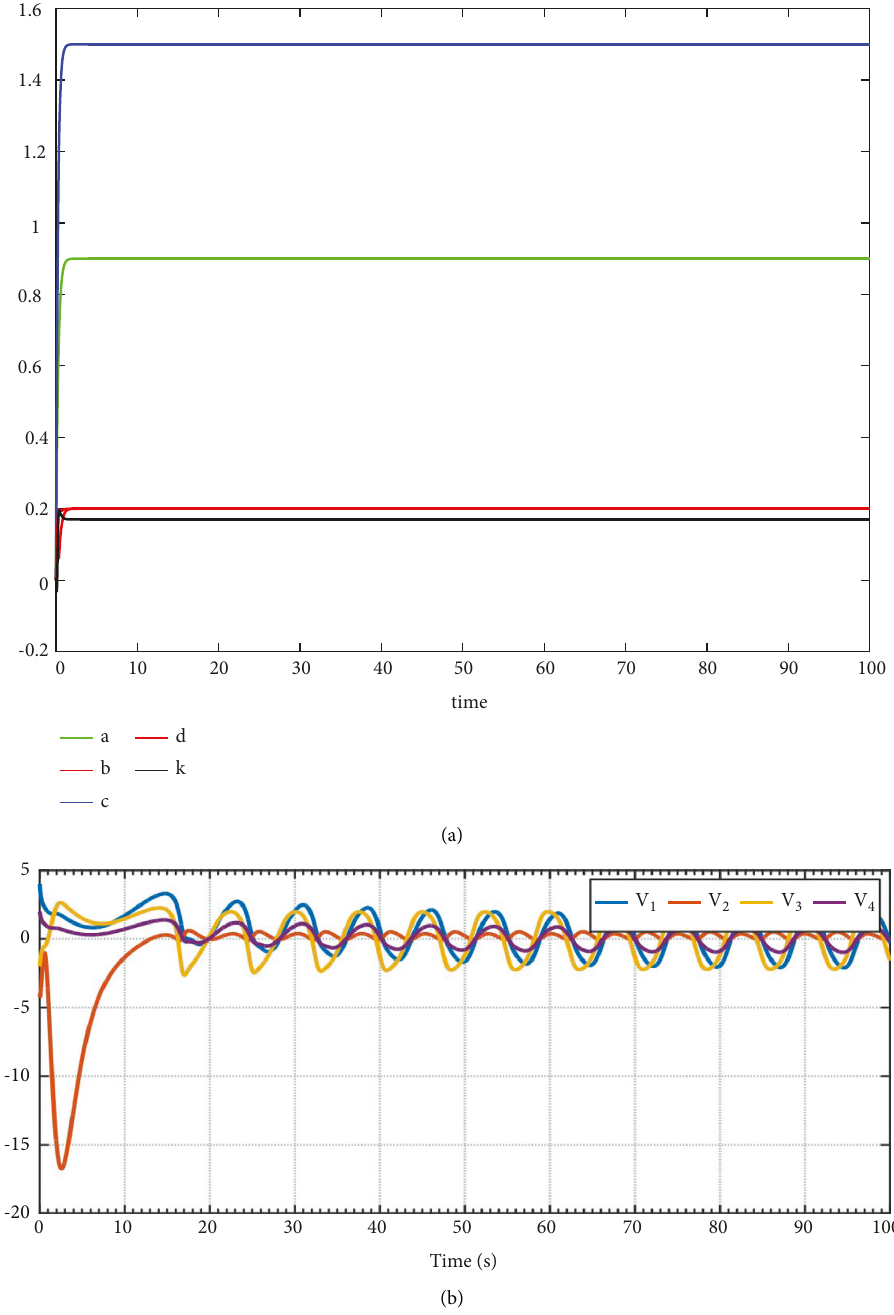
Figure 6: Synchronization of identical 4D hyperchaotic financial system. (a) 􏽢 a, 􏽢 b, 􏽢 c, 􏽢 d, and 􏽢 k represent the adaptation of unknown pa- ,v , v , and v represent the time-varying rameters. (b) v 1 2 3 4